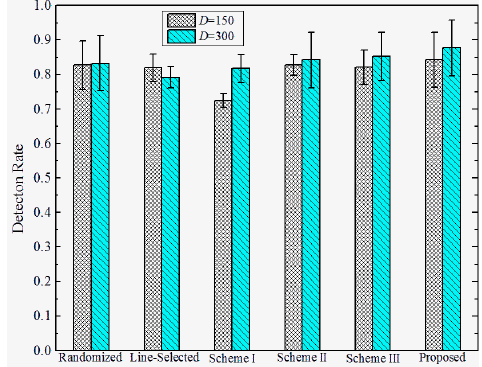
Figure 9. Detection rate of the proposed versus prior works under attack strategy II when σ = 100.